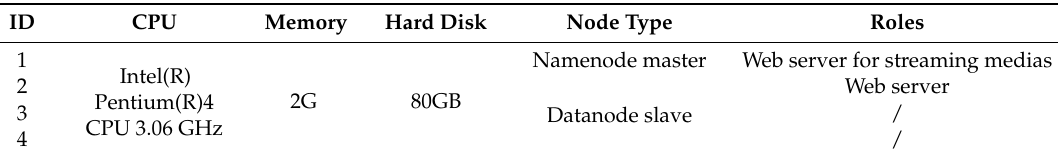
Table 1. Hardware and their parameters.